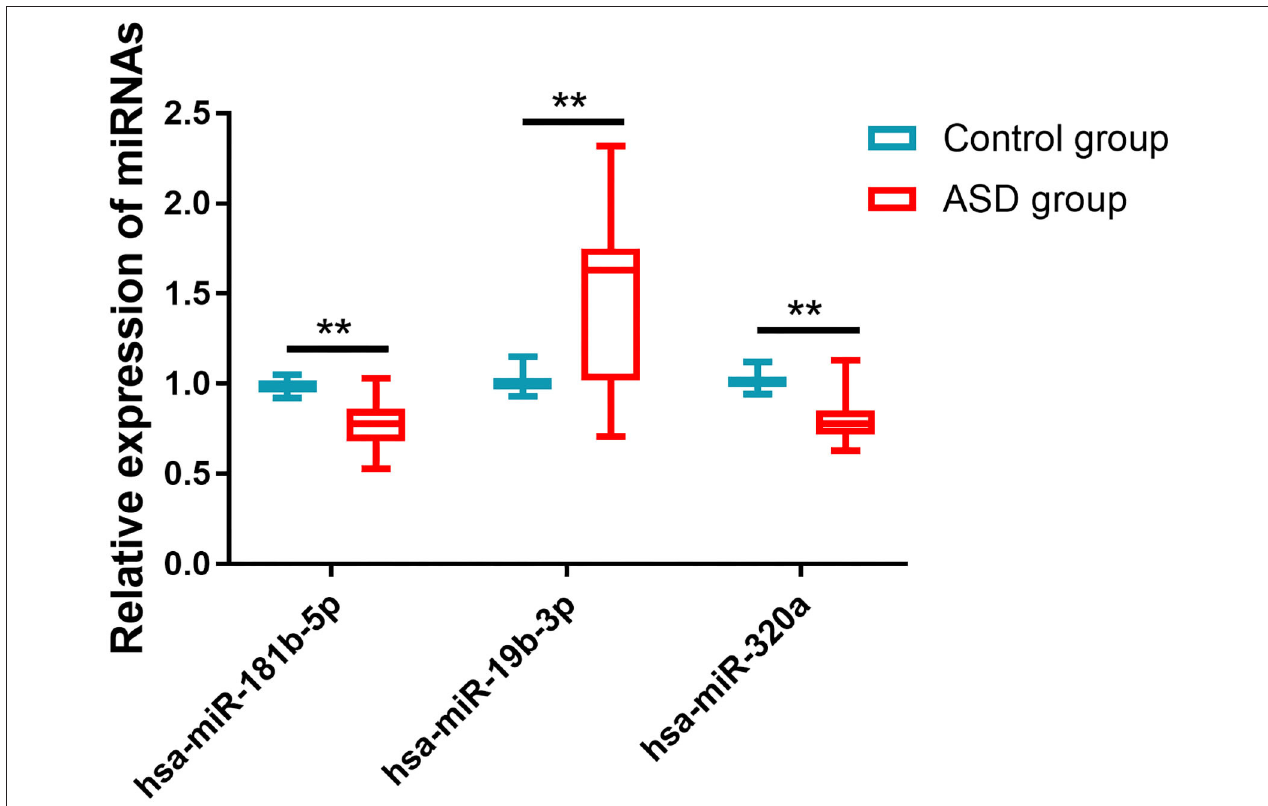
FIGURE 1 | The expressions of miRNAs in two groups. Compared with the control group, the ASD group had much lower expression levels of hsa-miR-181b-5p and hsa-miR-320a and significantly higher levels of hsa-miR-19b-3p. ** p < 0.001 vs. control group.